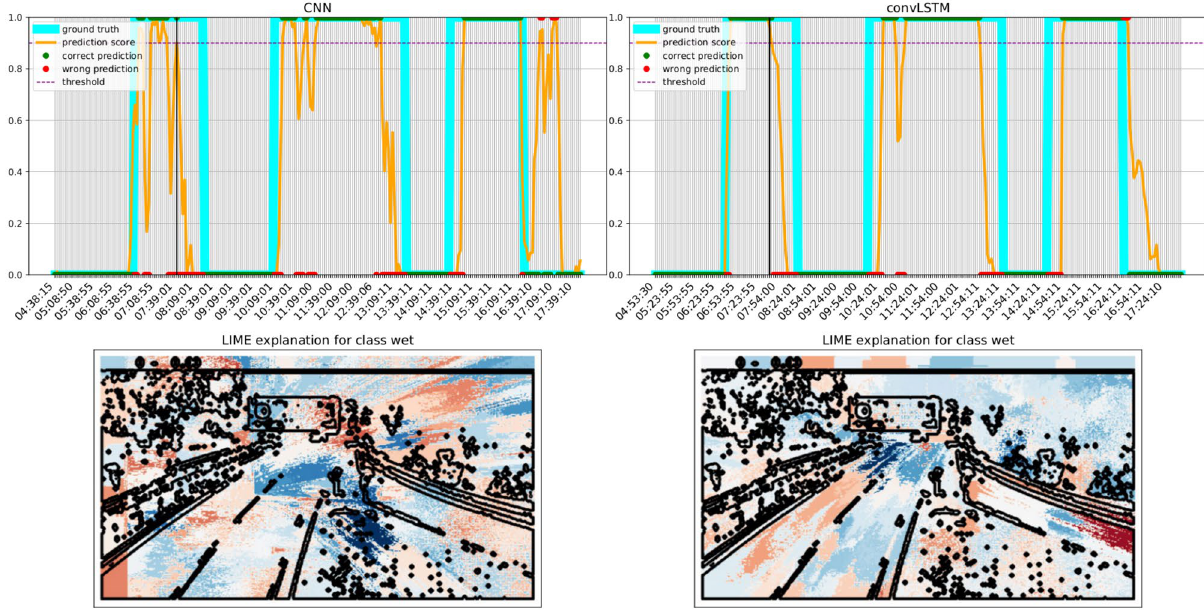
Figure 11. Comparison of the transition profile for a severe event. The convLSTM model especially improves the detection of the two events in the morning. Blue areas push the model towards the wet class, whereas red areas push towards the dry one. Best viewed in color.